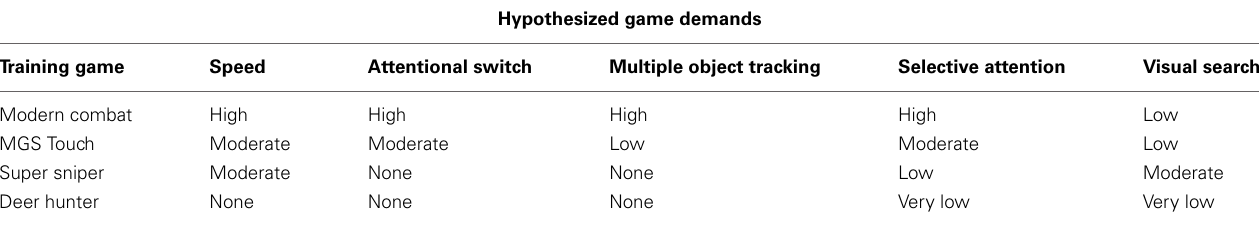
Table 1 | Summary of hypothesized demands of the videogames and cognitive tasks